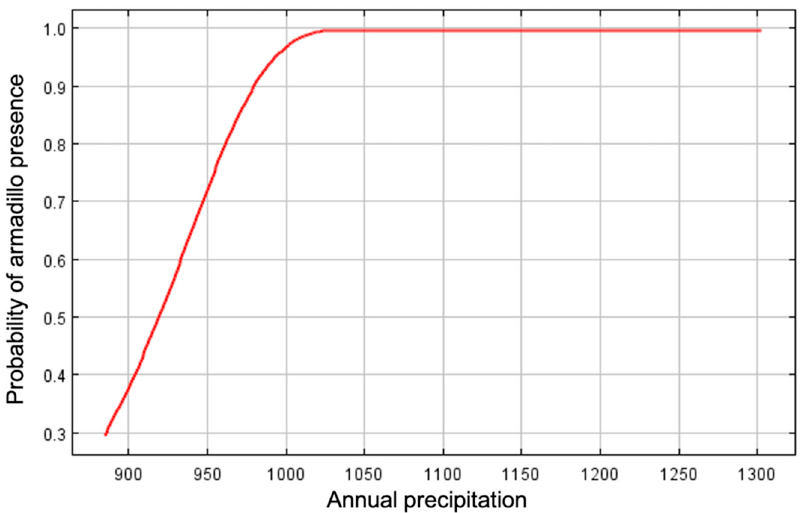
Figure 7. Marginal response curve for mean annual precipitation (mm) as an environmental predic- tor for presence of nine-banded armadillos in southern Illinois during 2016–2020. Probability of ar- madillo presence increased with precipitation.